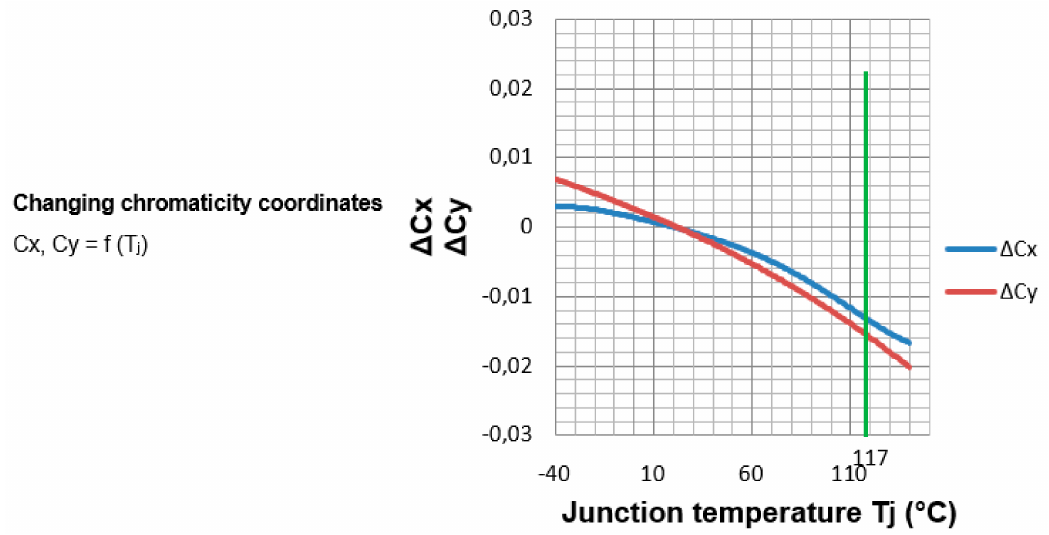
Figure 26. Junction temperature (Tj) vs. change of chromaticity coordinates. Source: our own elaboration and data sheet LED Osram LUW CQAR